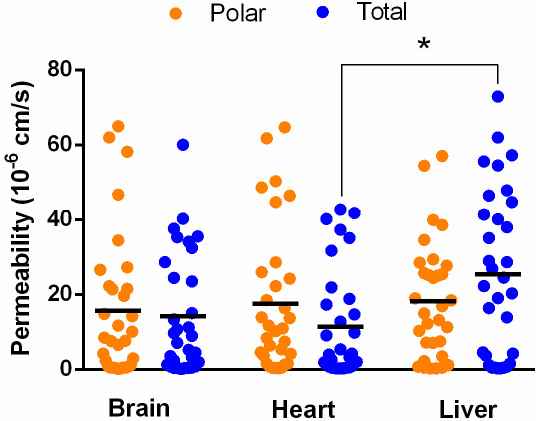
Figure 7. Permeability of 32 drugs on tissue-specific artificial membranes. Scatter plot with a line depicting the mean value with three replicates; significant differences are marked with an asterisk (* p < 0.05, one-way ANOVA, Tukey’s multiple comparisons test). For details on the measured data see Table S2 in the Supplementary Material.